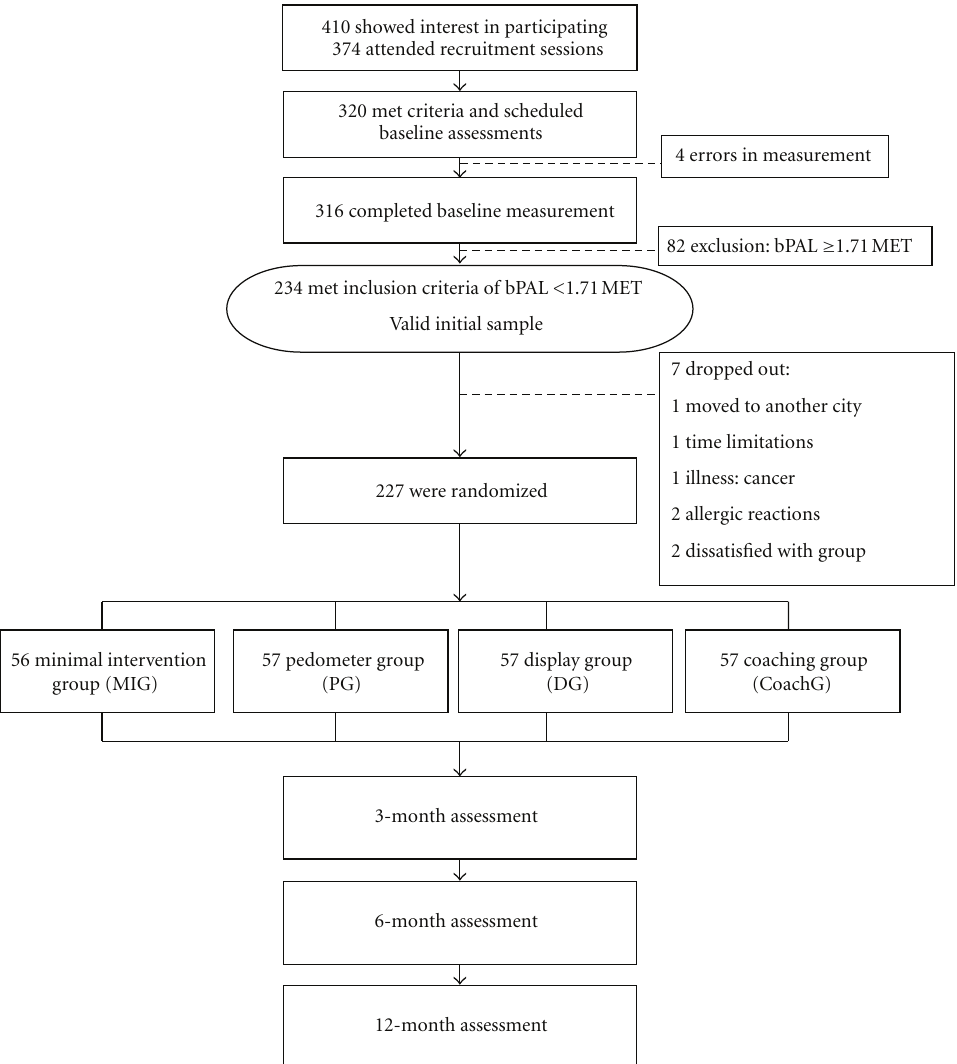
Figure 1: Participants flow from screening to randomization. All four groups received the SWA during the intervention period and the posttests. The minimal intervention group received no feedback during the 4-week intervention period. The pedometer group received feedback on the daily step count and a step diary during the 4-week intervention period. The display group and coaching group received a SenseWear display and an activity diary during the 4-week intervention